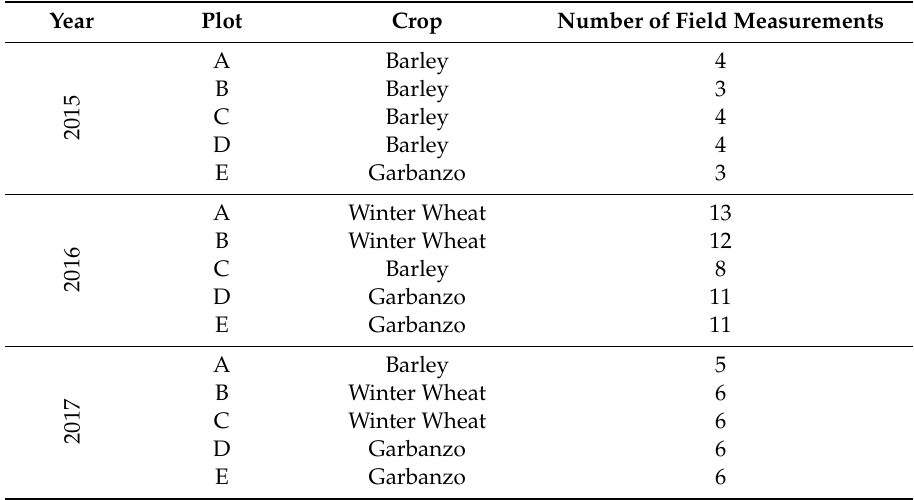
Table 2. Summary table of field sampling plots for each year.